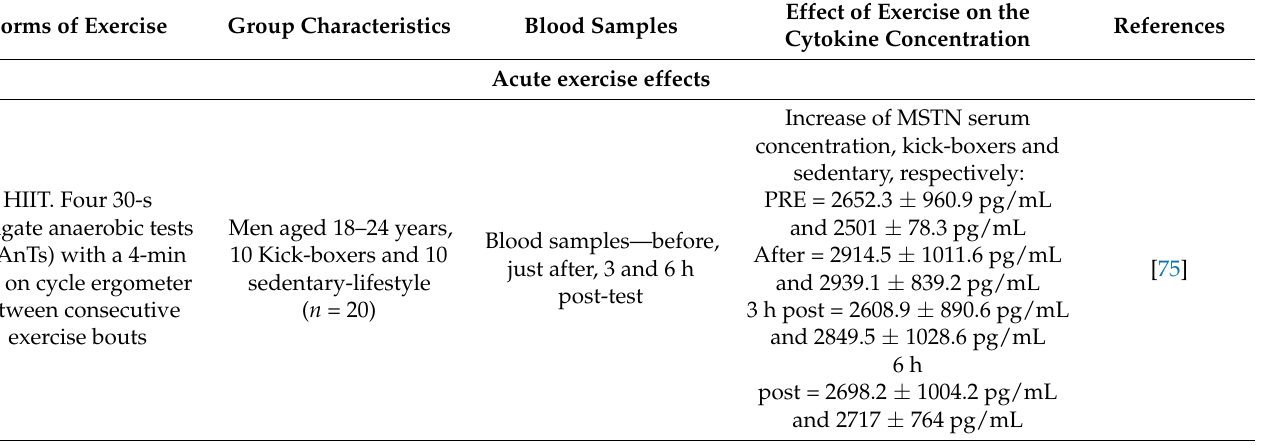
Table 2. Effects of exercise on